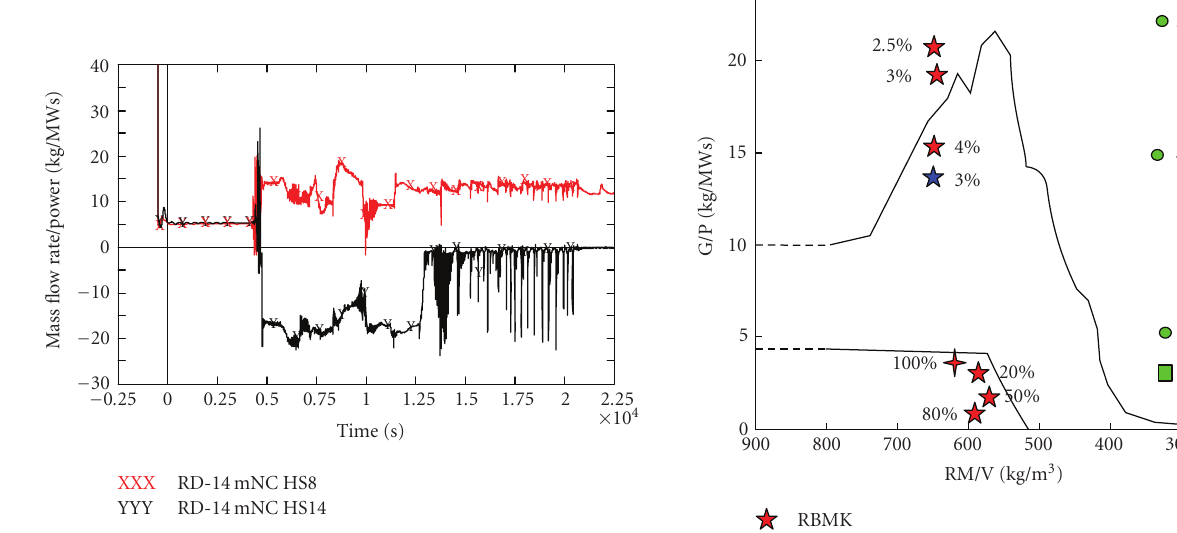
Figure 7: Channel-to-channel natural circulation mode for the RD- 14m calculated data.